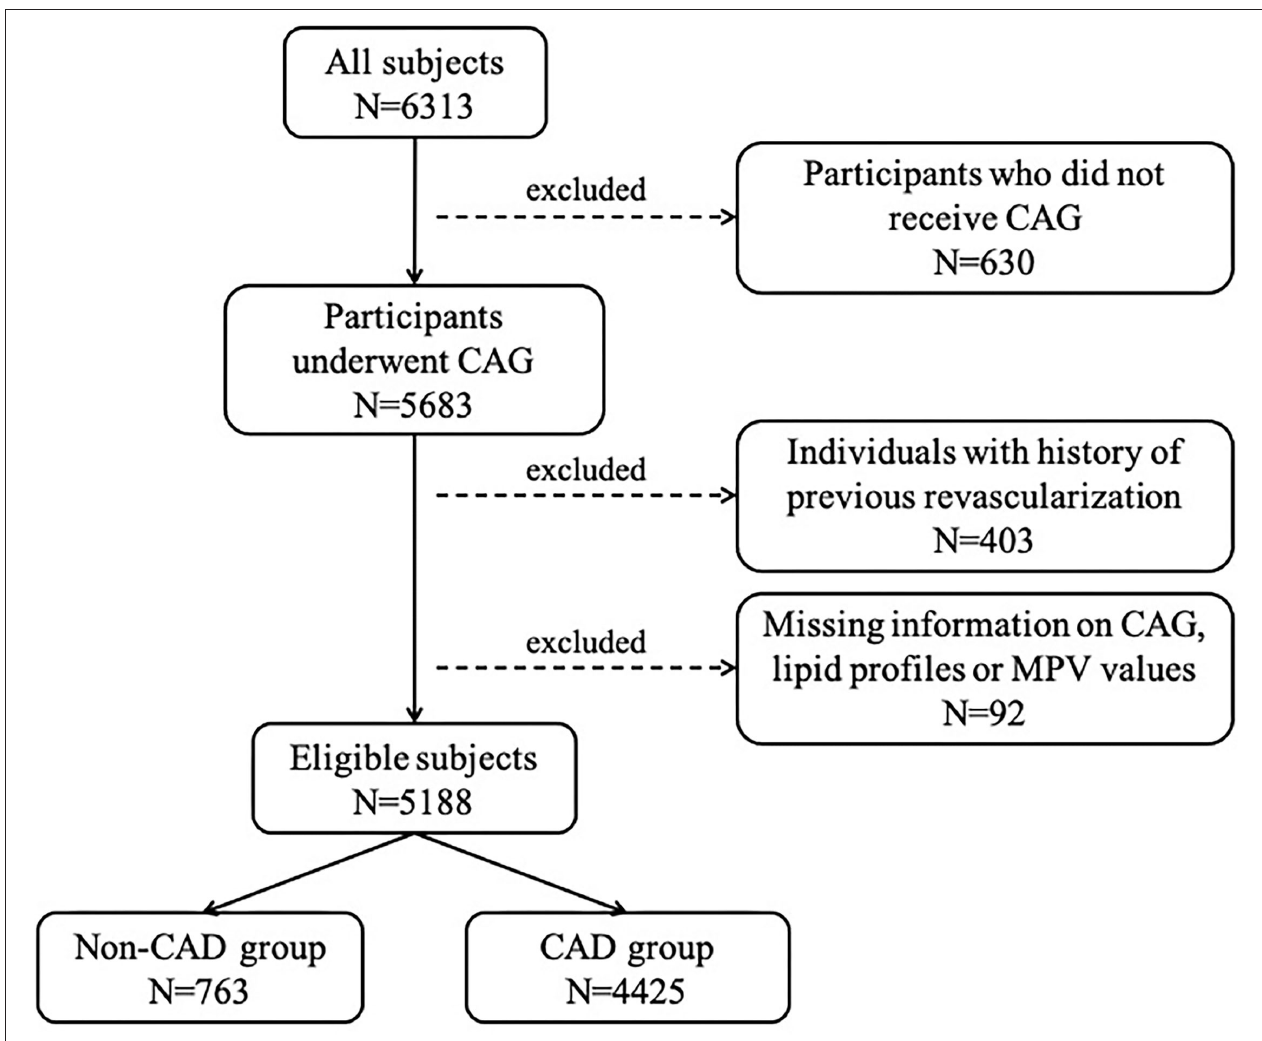
FIGURE 1 | Flow chart depicting participants enrollment procedure. CAG, coronary angiography; MPV, mean platelet volume; CAD, coronary artery